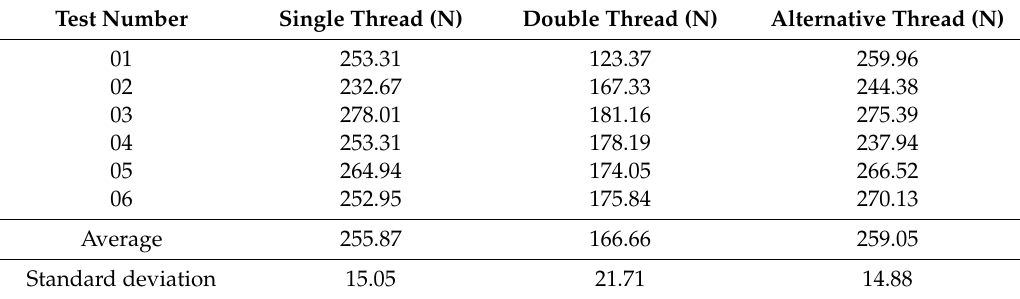
Figure 4. Typical bending test results: Pressing load vs. compression distance. Table 2. Bending test results: strength vs.